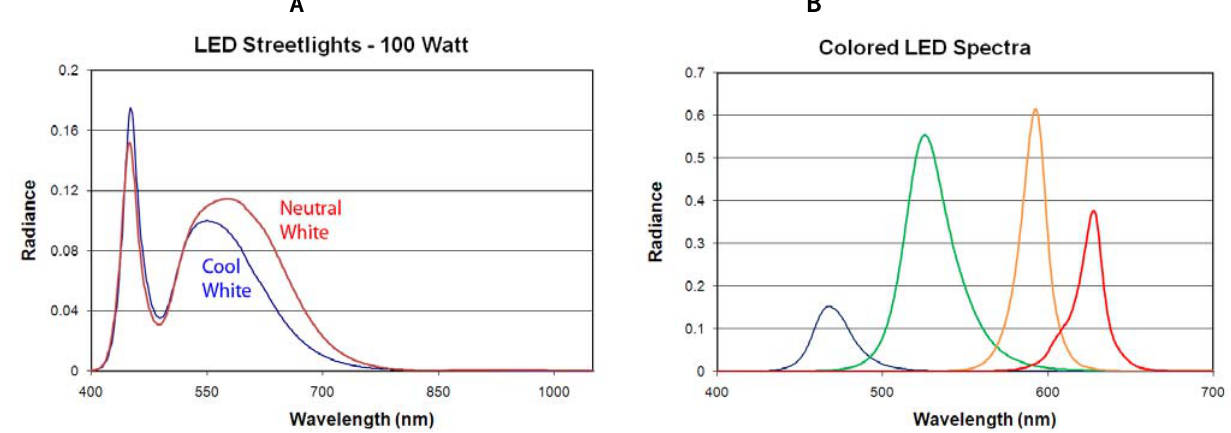
Figure 17. Spectra of LED lamps. A) Comparison of two white LED